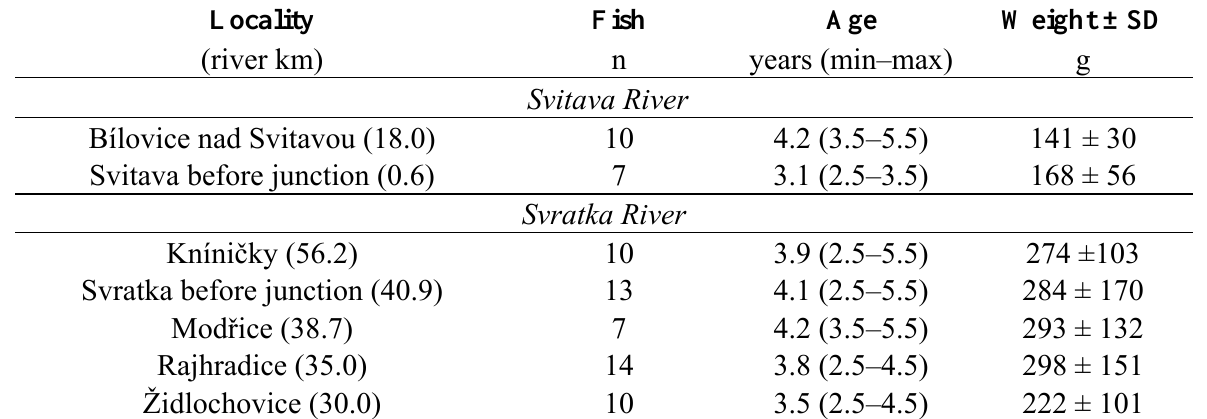
Table 1. Characteristics of male chub ( Leuciscus cephalus L.) from sampling sites.